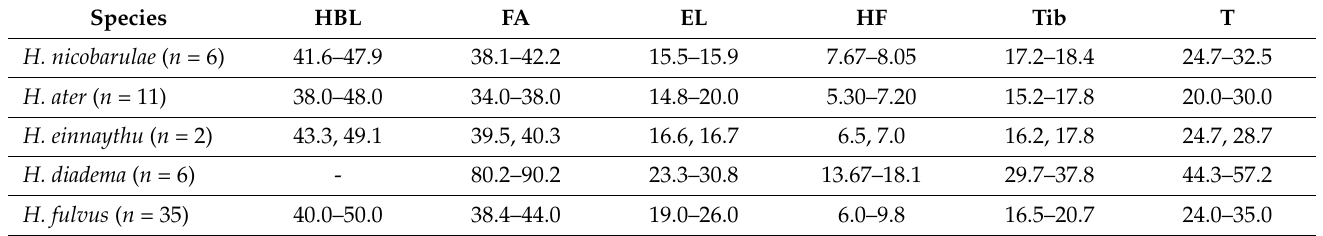
Table 1. External morphological measurements (mm) of Hipposideros spp. [3,34–36]. The measure- ments are represented in range (minimum and maximum). HBL: head and body length; FA: forearm length; EL: ear length; HF: hind foot length; Tib: tibia length; T: tail